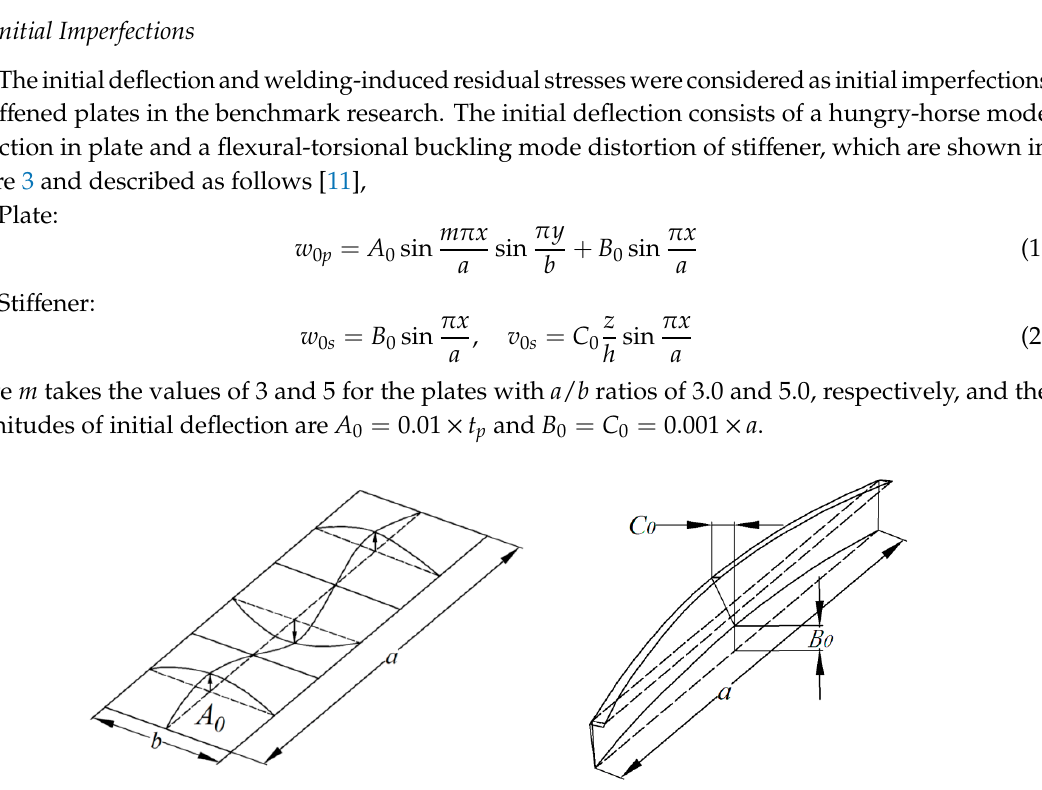
Figure 2. 1/2 + 1/2 span stiffened plate model. Table 2. Boundary conditions for the 1/2+1/2 span model.